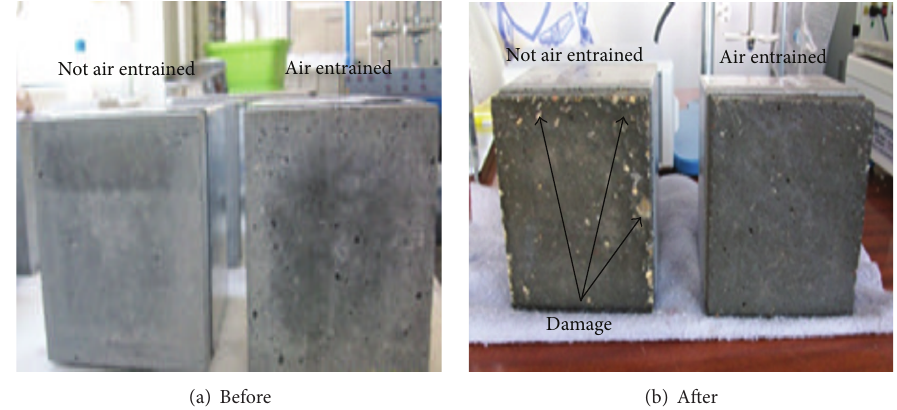
Figure 8: The effect of air entraining.